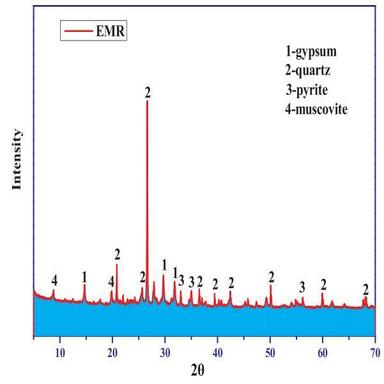
XRD patterns of EMR.